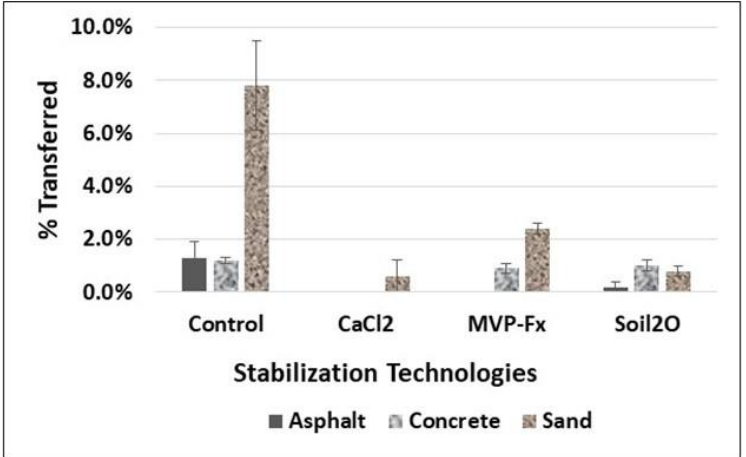
Figure 14. Percent Transfer of Sr-85 Contaminated Particles for Straight-line Walking Experiments.